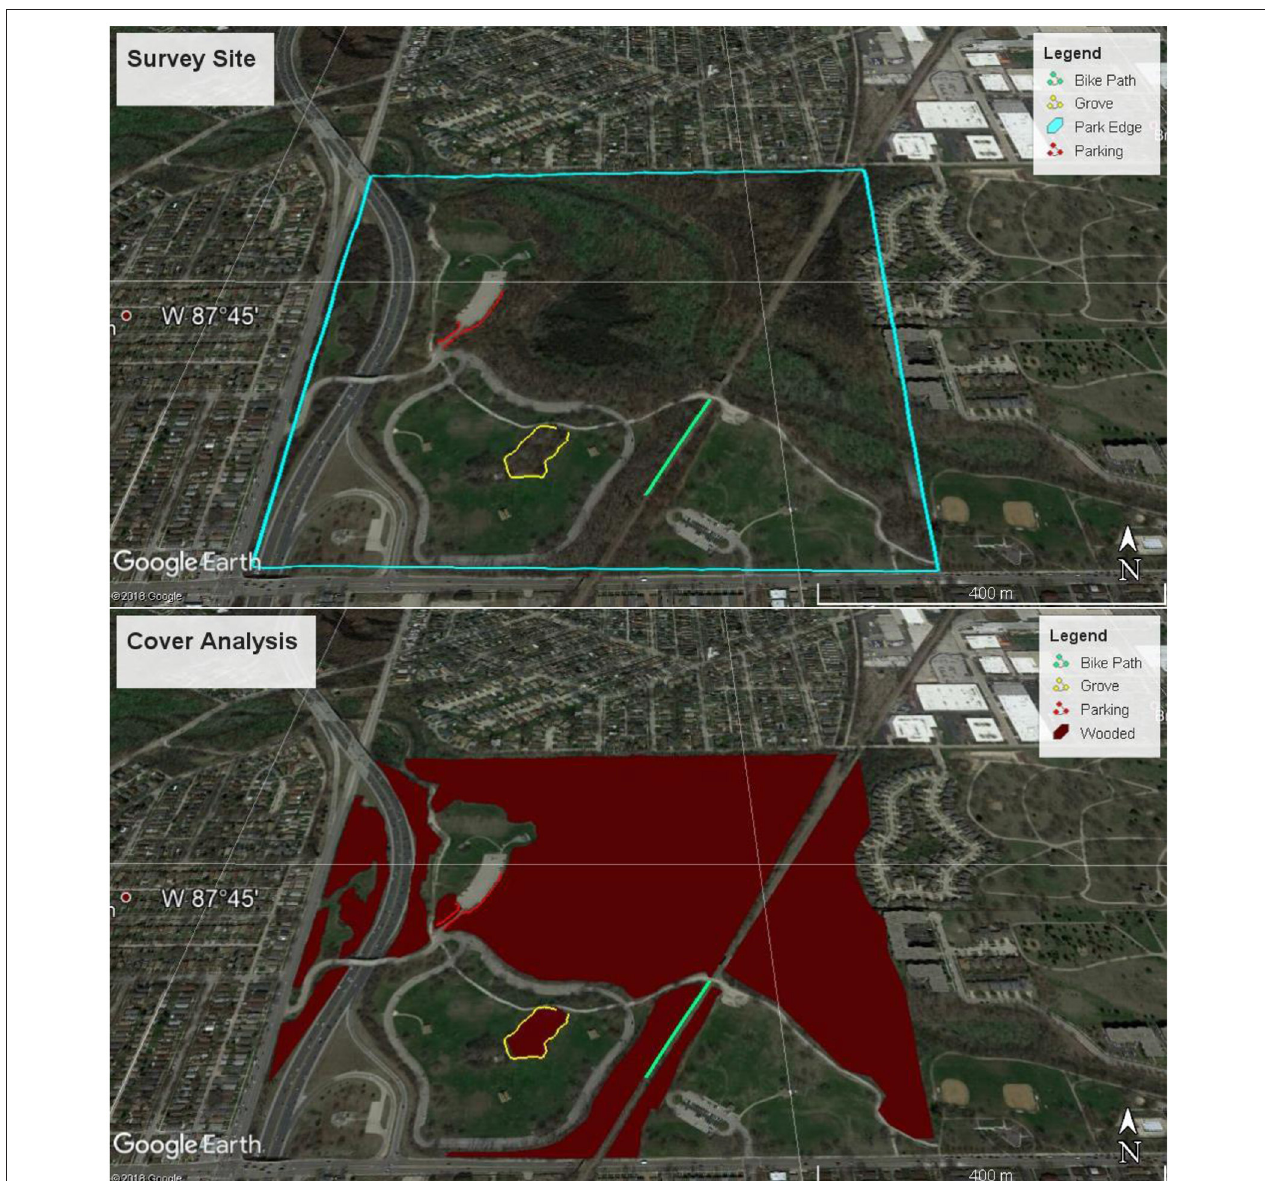
FIGURE 1 | The three locations sampled in LaBagh Woods during summer 2017 and the study boundary (top) and the classified wooded area with an understory at LaBagh Woods (bottom).